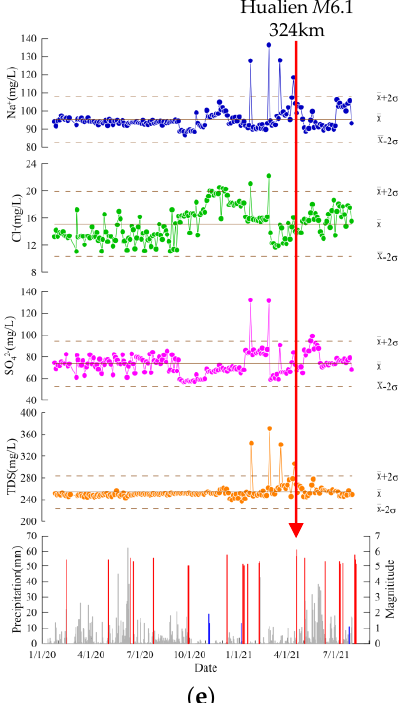
Figure 7. Temporal variations of concentration of Na + , Cl − , SO 42 − , TDS and precipitation: ( a ) the Tadou spring (W03); ( b ) the Longmen spring (W04); ( c ) the Tainei spring (W12); ( d ) the Gangwei spring (W23); ( e ) the Guian spring (W29). Blue bars show the near-field M L ≥ 1.0 earthquakes within 50 km and red bars show the far-field M S ≥ 5.0 earthquakes with 500 km; gray bars show the daily precipitation. Table 3. The precursory anomalies of five thermal springs before the Hualien M 6.1 earthquake on April 18, 2021. Thermal Spring Code